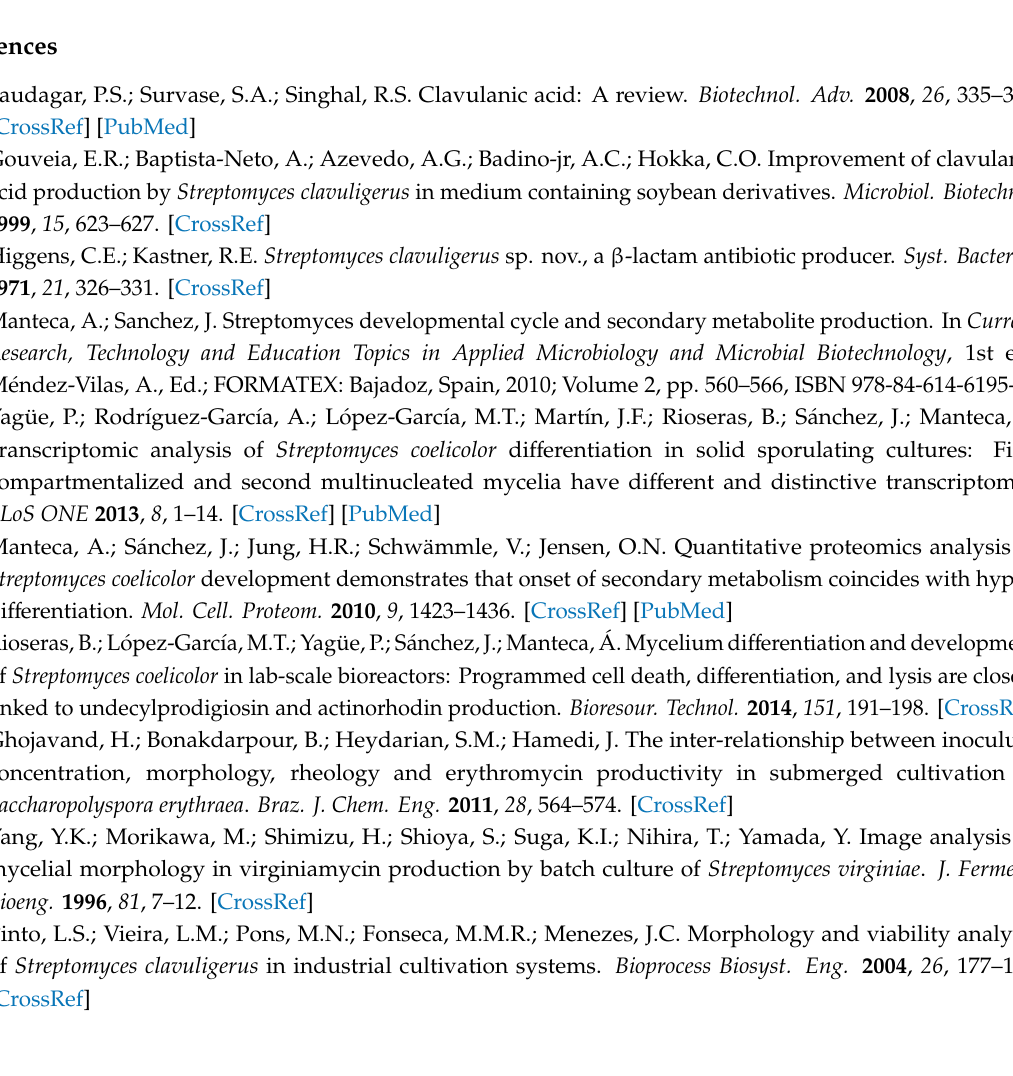
Figure S1: Calibration curve for quantification of clavulanic acid, Figure S2: Three-dimensional response surface plot showing the simultaneous e ff ects of inoculum and size on CA concentration, Figure S3: Pellet disintegration of Streptomyces clavuligerus ATCC 27064 grown in TSB medium after 72 h of culture, Table S1. Analysis of variance applied to the regression model used for the clavulanic acid